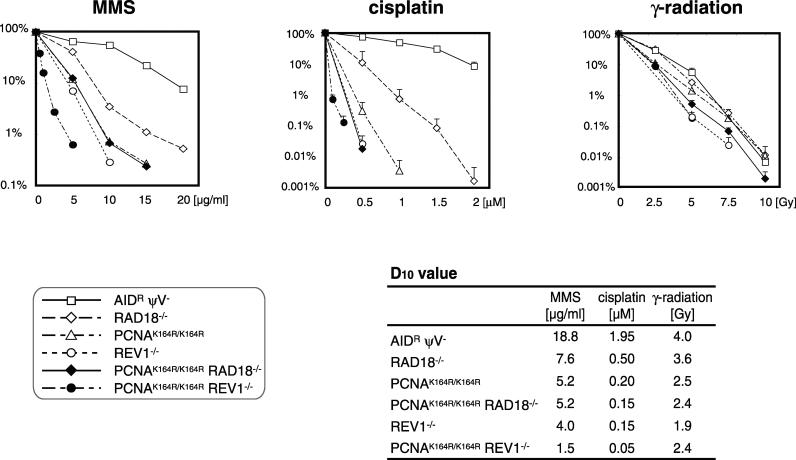
Colony Survival Curves after Exposure to DNA-Damaging AgentsThe values of DNA damaging agents, which give 10% cell viability, are also summarized (D
10 values).